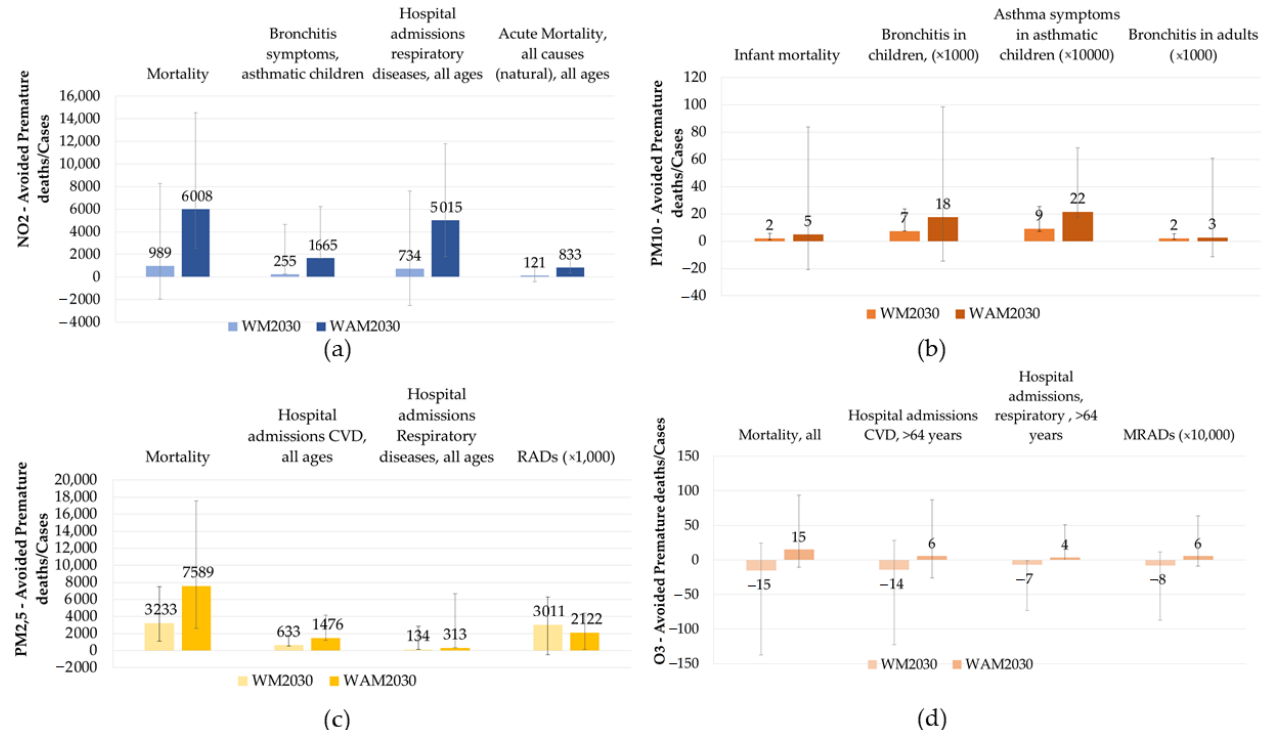
Figure 3. Avoided health impacts by pollutant: ( a ) NO 2 , ( b ) PM 10 , ( c ) PM 2.5 , and ( d ) O 3 . The results of the uncertainty analysis (from the CIs of the CRF and relative risk (RR) values) are shown as error bars.